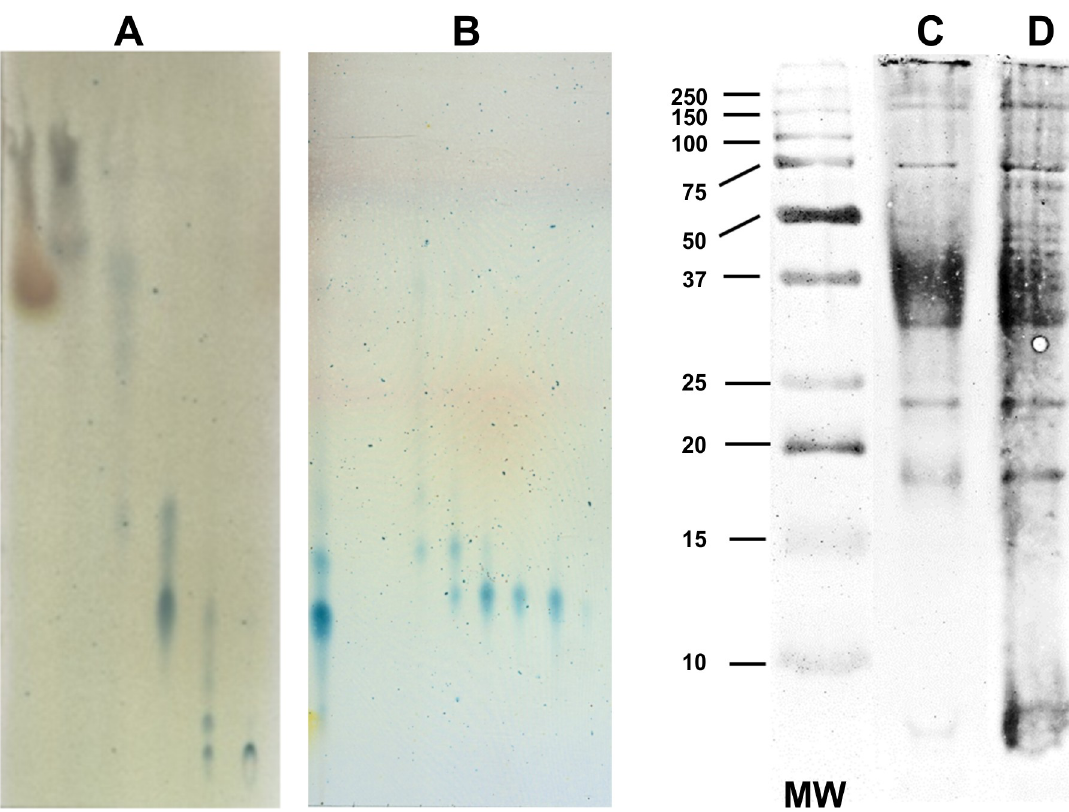
Fig 1. Isolation of Di- O -acyl trehalose and mycobacterial antigens. Thin-layer chromatography of M . fortuitum ATCC 6841 unfractionated lipids extracted with CHCl 3 /CH 3 OH/H 2 O (A). The spots with Rf value of 0.37 correspond to isolated DAT (B). Immunoblot shows protein profiles of untreated BCG cell-walls (C) and cell walls delipidated with CHCl 3 /CH 3 OH/H 2 O